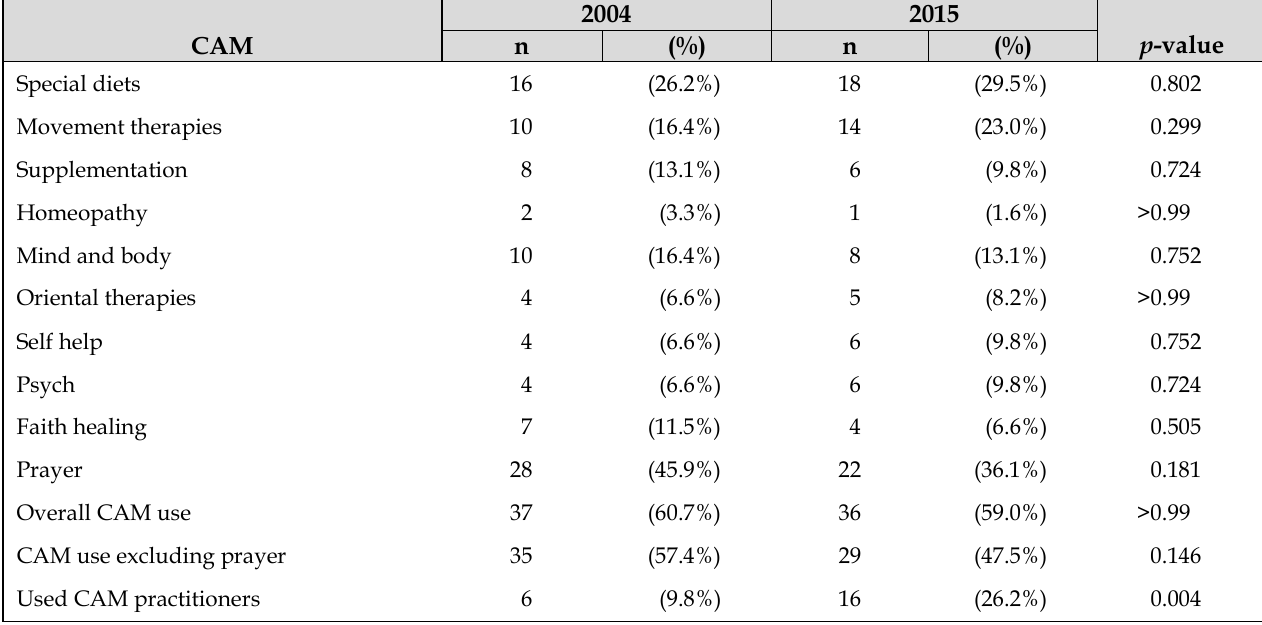
Table 4 CAM usage patterns for those reporting usage in both 2004 and 2015 surveys (n=61)